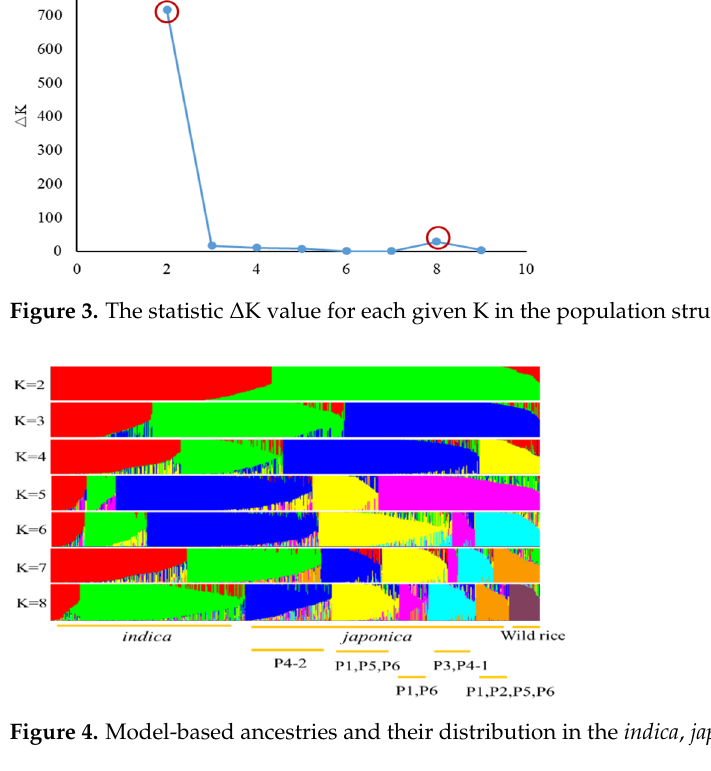
Figure 4. Model ‐ based ancestries and their distribution in the indica , japonica , and wild rice groups. 3.3. Genetic Variation in Rice Landraces before and after Short-Term Domestication by Ethnic